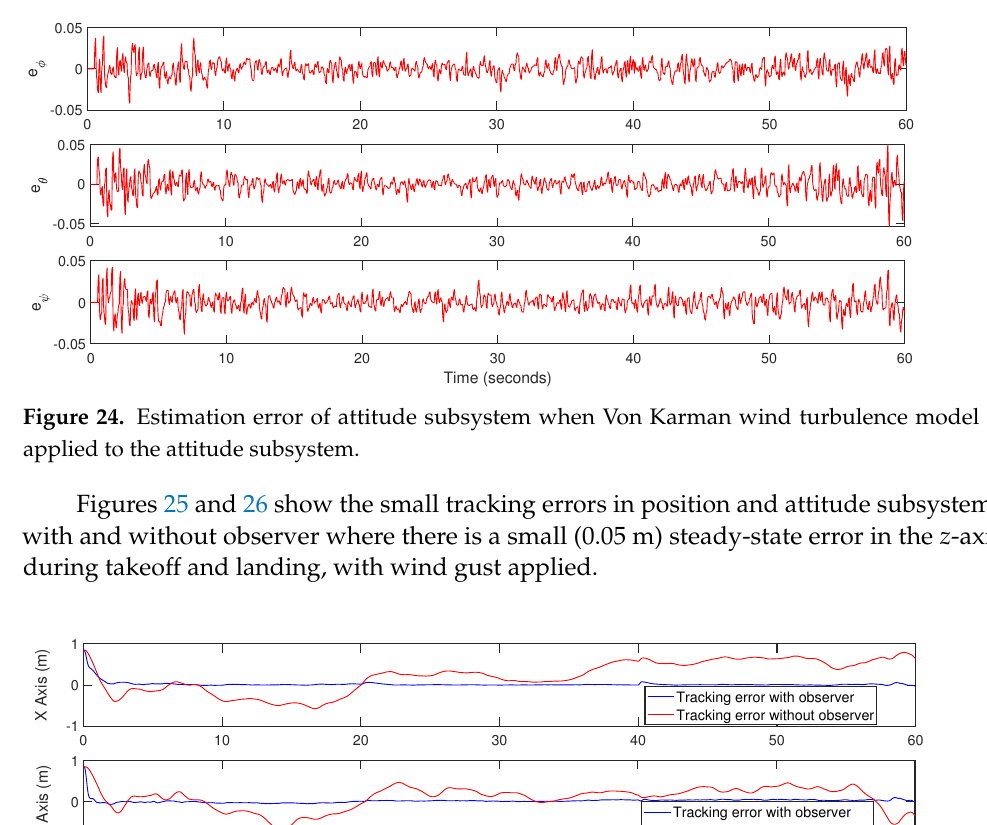
Figure 23. Estimation error of position subsystem when Von Karman wind turbulence model applied to position subsystem.